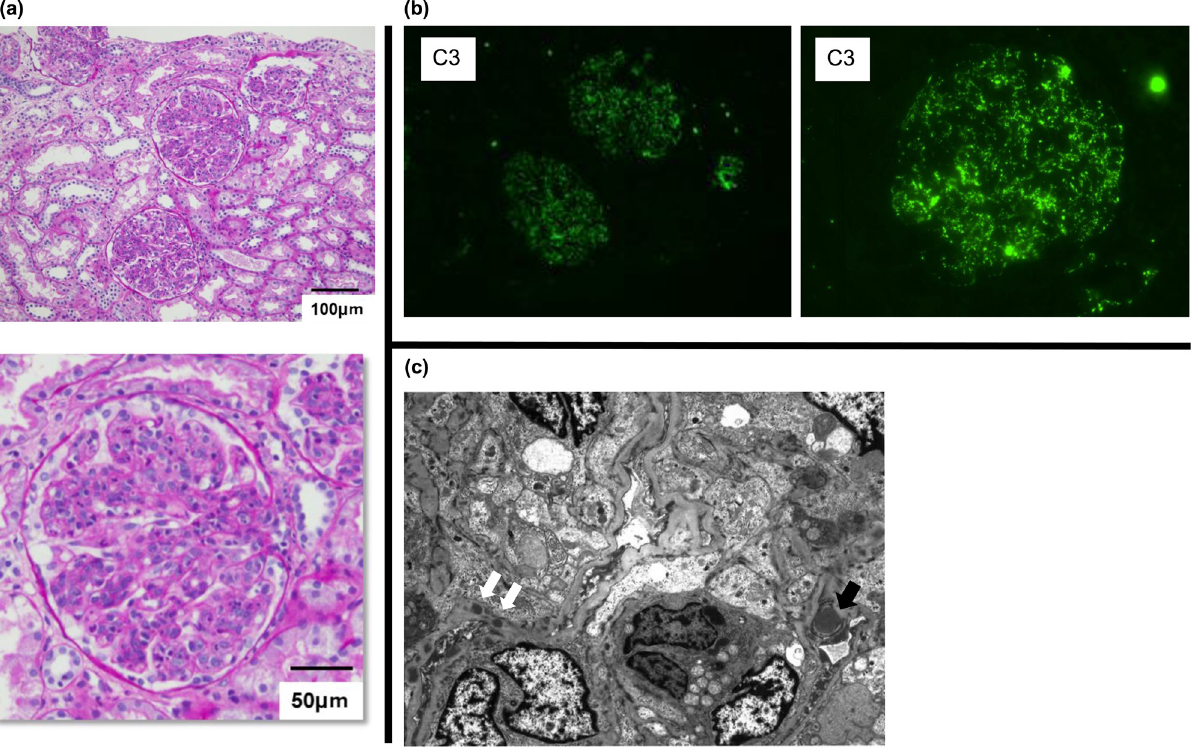
Figure 1: Pathological observation by percutaneous renal biopsy. ( a ) PAS stain. ( b ) Fluorescent antibody method. ( c ) Electronic microscope. According to pathological observation, glomerulus in fl ammatory cells in fi ltrating into the glomerular tuft increased. Glomerular C3 deposition ( starry sky pattern ) was observed by fl uorescent antibody method. Electronic microscope fi nding of a portion of a glomerulus. Subepithelial dense deposit ( hump; black arrow ) and intramembranous deposits ( white arrows ) are shown. C3: complement